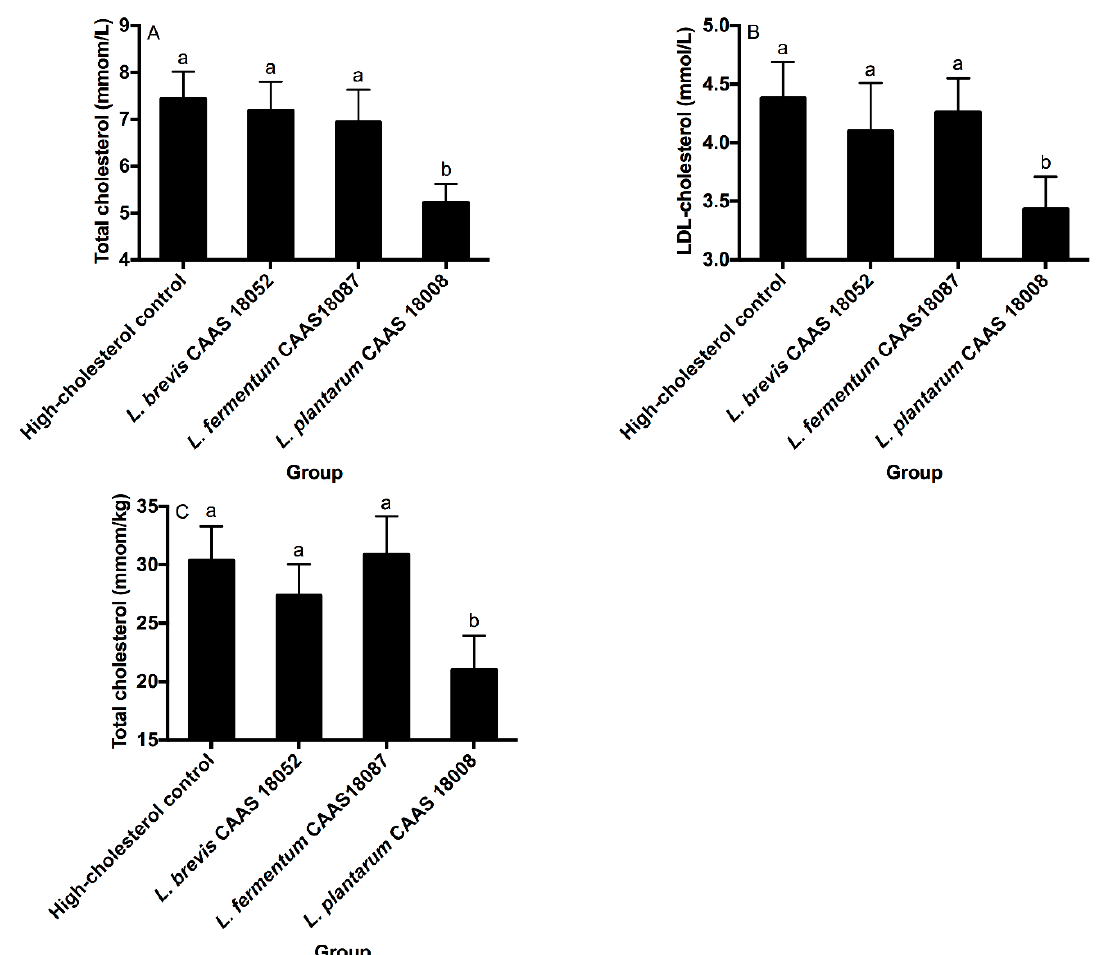
Figure 4. Serum total cholesterol ( A ), LDL-cholesterol ( B ) and hepatic total cholesterol ( C ) levels of the different groups. Data are represented as the mean ± SD ( n = 8). Means not sharing a common letter differ significantly from each other ( p < 0.05).